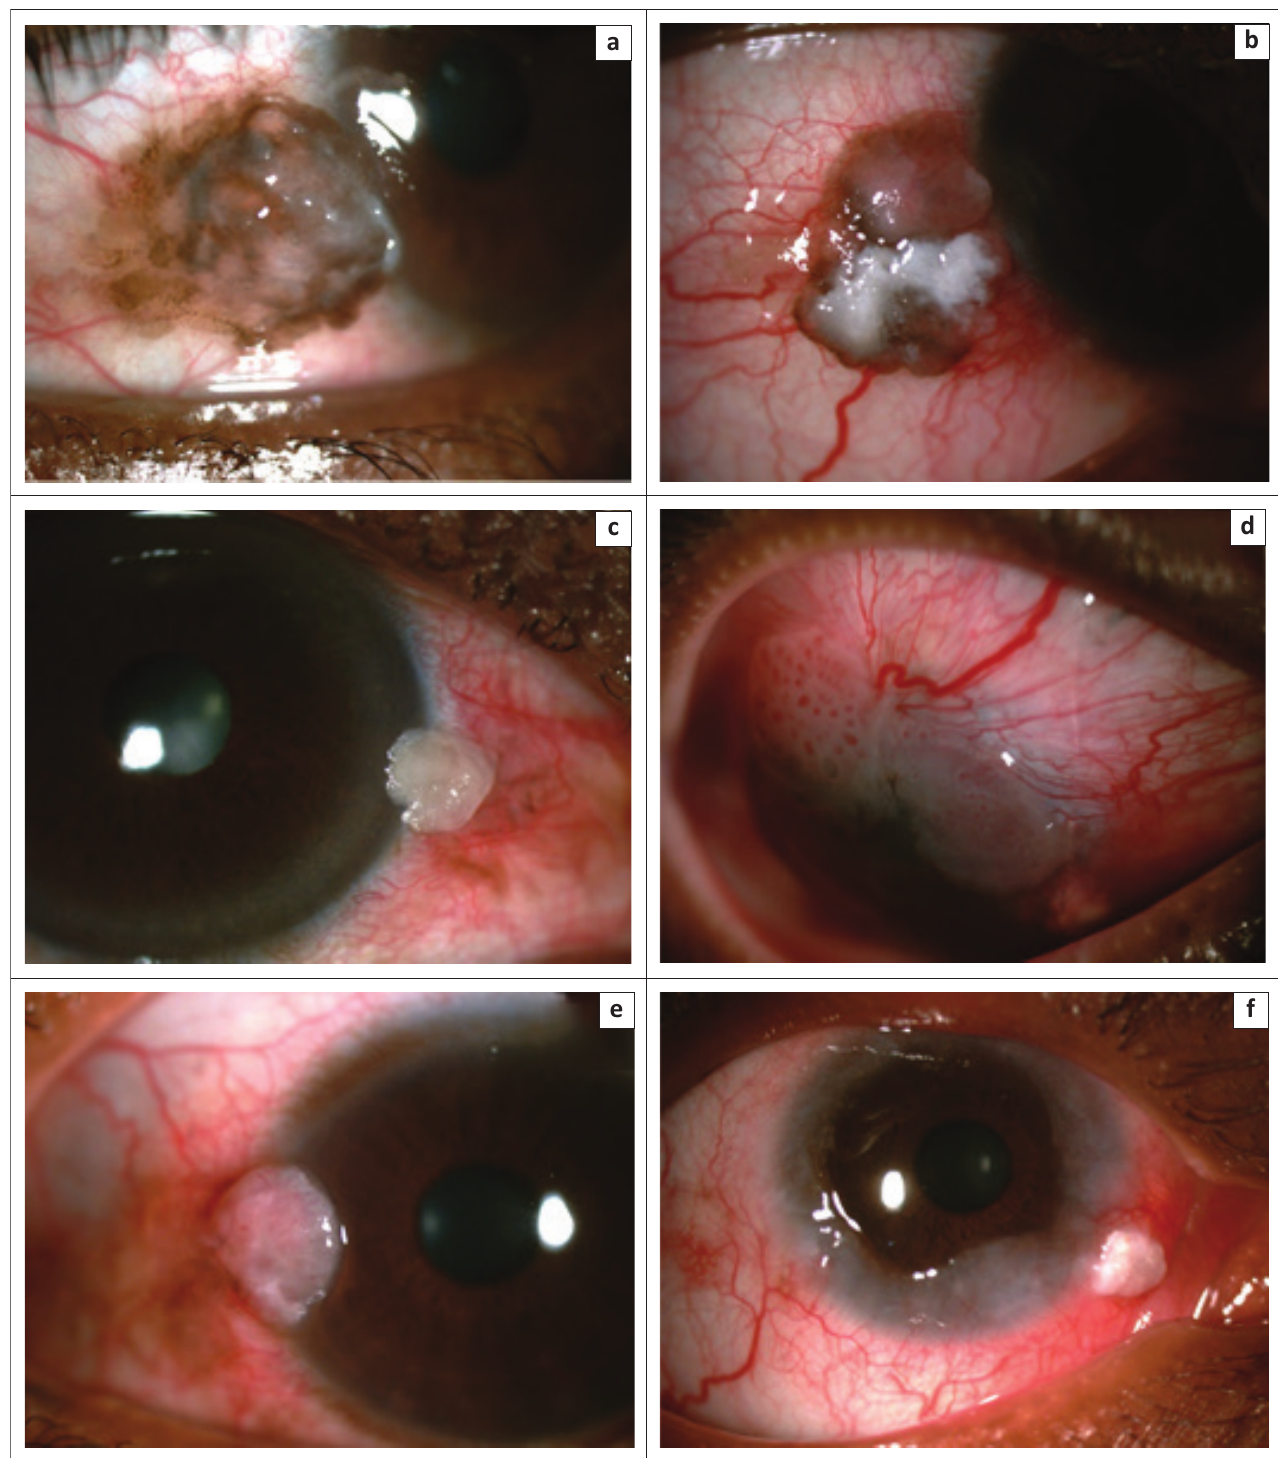
FIGURE 1: Anterior segment images of ocular surface squamous neoplasia morphology. (a) Gelatinous, (b) gelatinous with an area of leukoplakia, (c) leukoplakic, (d) papilliform, (e) nodular, (f) diffused with an area of